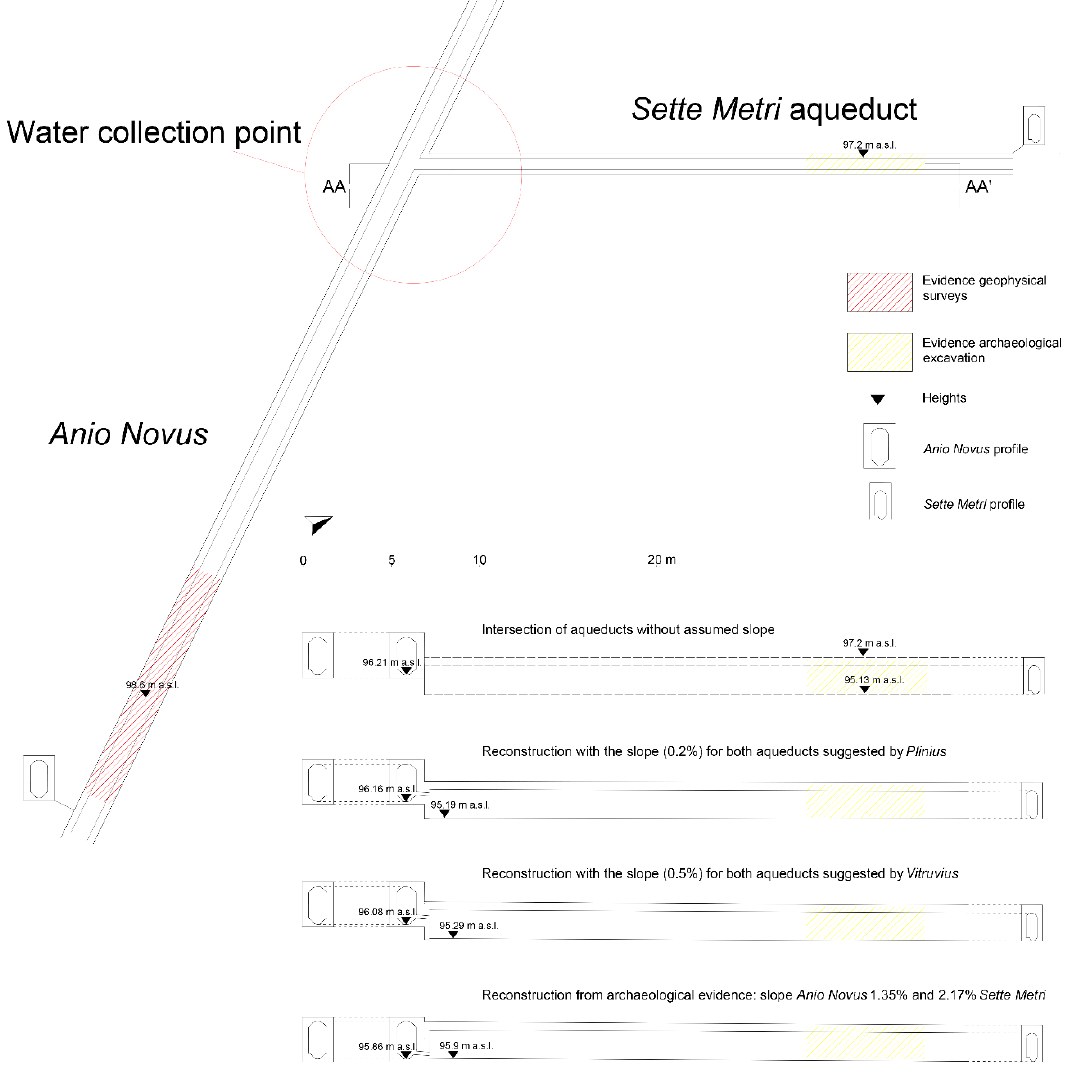
Figure 9. Map and profiles of the possible intersection between the Anio Novus and the Sette Metri